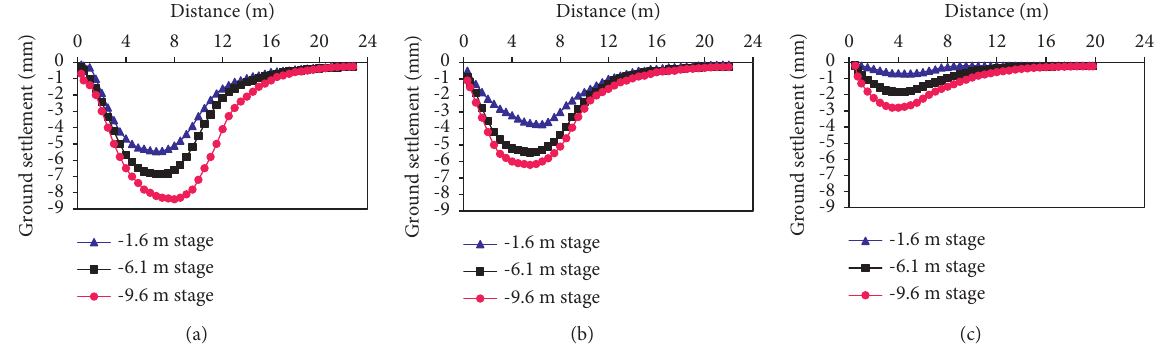
Figure 23: Influence of the application of steel and servo axial loading capacities on the profile of ground surface influence zone settlement. (a) First case. (b) Second case. (c) Third